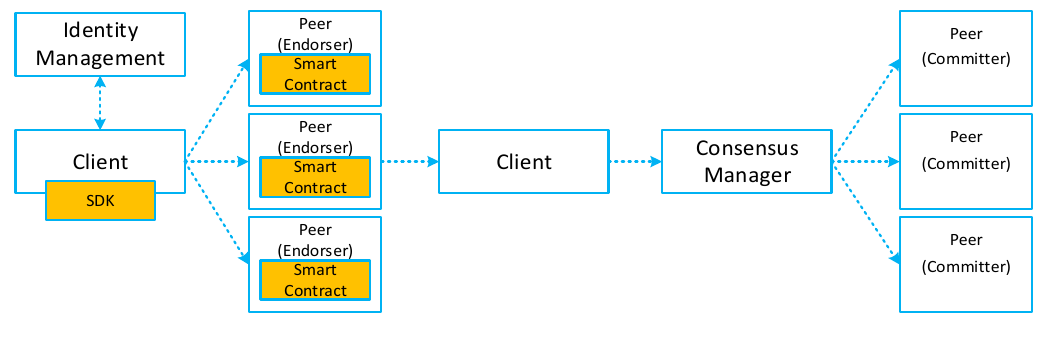
Figure 4 . Detailed transaction execution work flow. Figure 4. Detailed transaction execution work